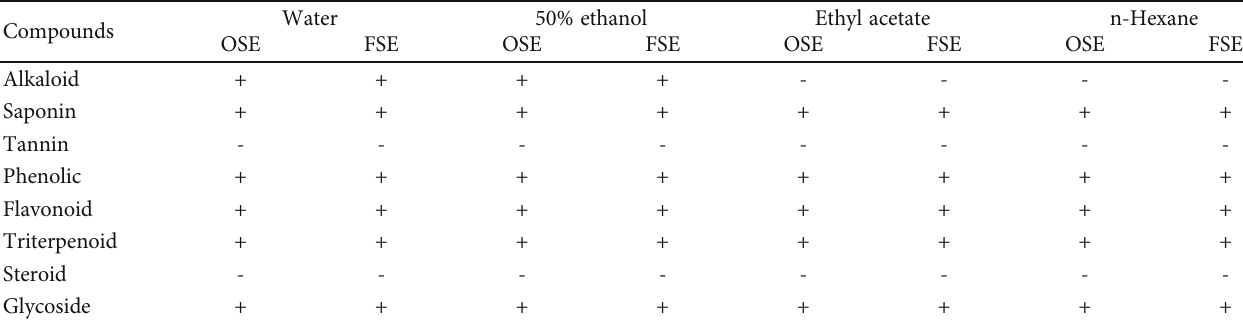
Figure 1: Yield of Pangium edule crude seed extracts. Table 2: Qualitative phytochemical screening of Pangium edule crude seed